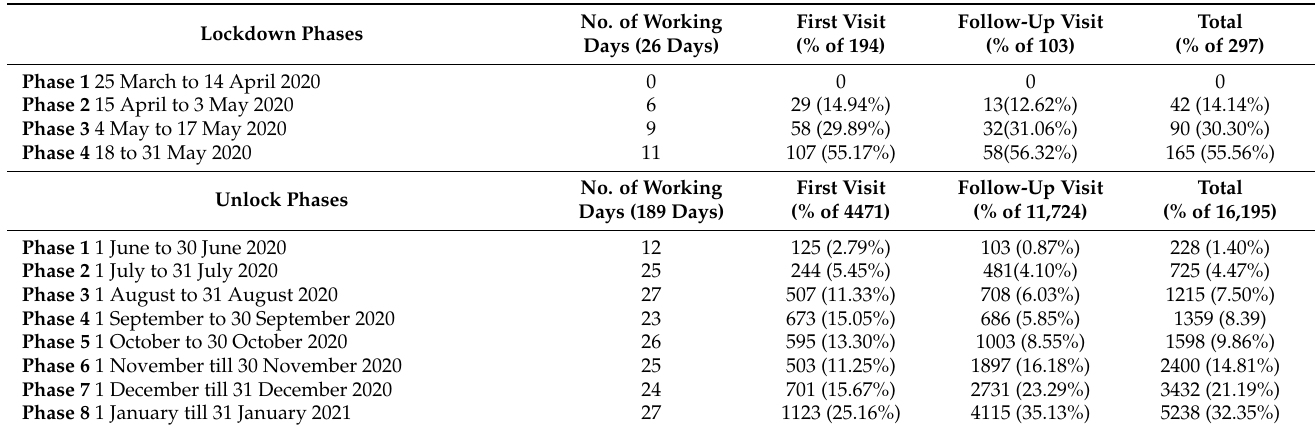
Table 1. The number of working days, number, and percentages (%) of the patients visited the dental school for their first and follow-up visit during the different lockdown and unlock phases.